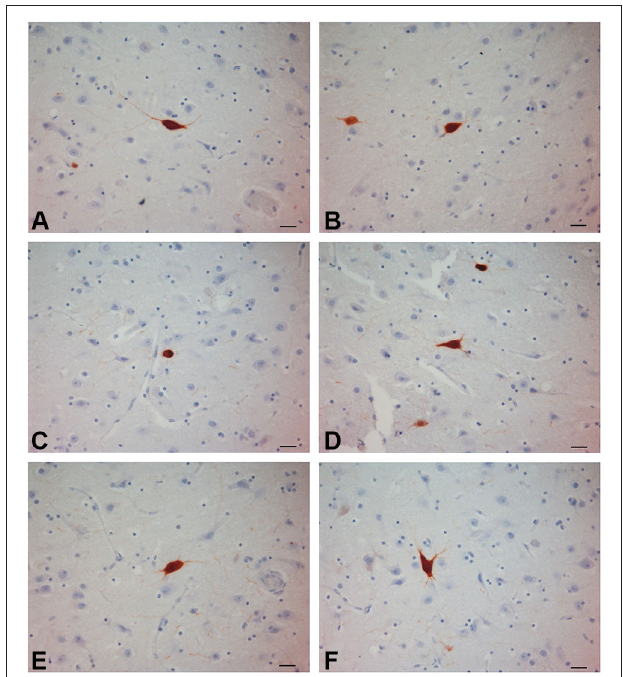
FIGURE 4 | PV-ir neurons in the chimpanzee claustrum . (A–F) Scale bars = 20 µ m.